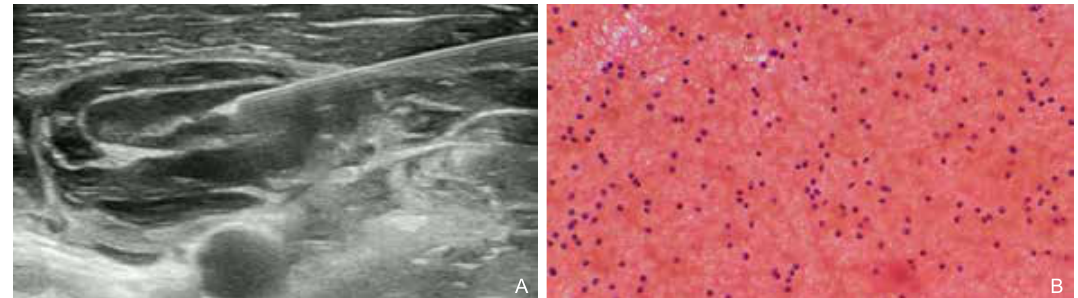
Figure 5 FNA and FNAC of the left cervical lymph node. (A) FNA was operated on the lymph node in fashion of multiple passages combined with targeted aspiration of the suspected foci of calcification; (B) Microscopic examination demonstrated abundant of normal lymphocytes and erythrocytes, but no heterocyst (original magnification ×